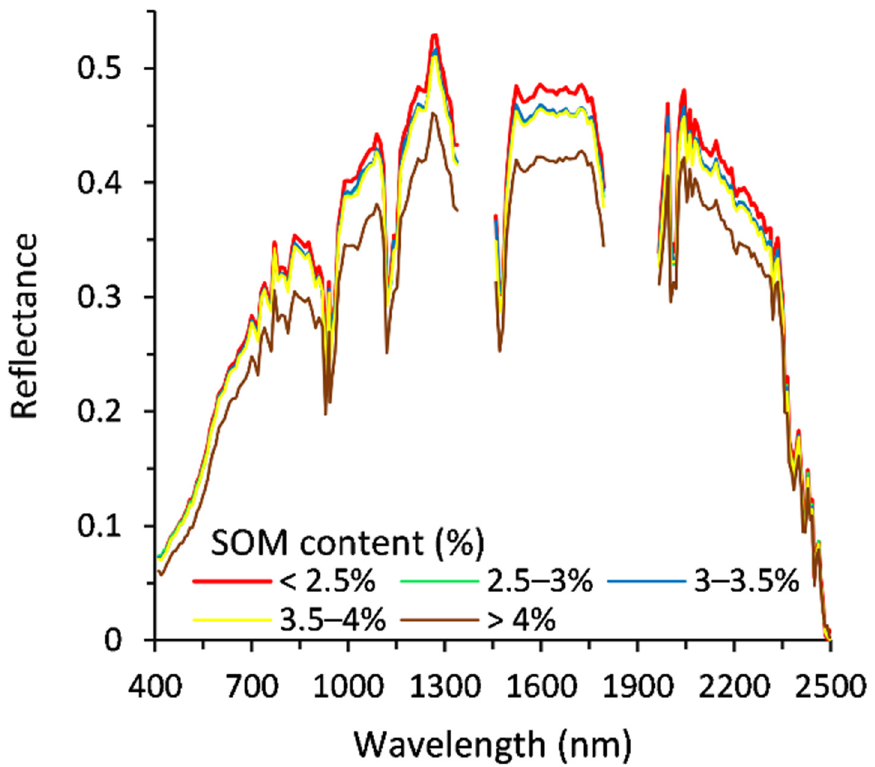
Figure 3. Mean of PRISMA hyperspectral reflectance curves for different classes of soil organic matter (SOM) content.